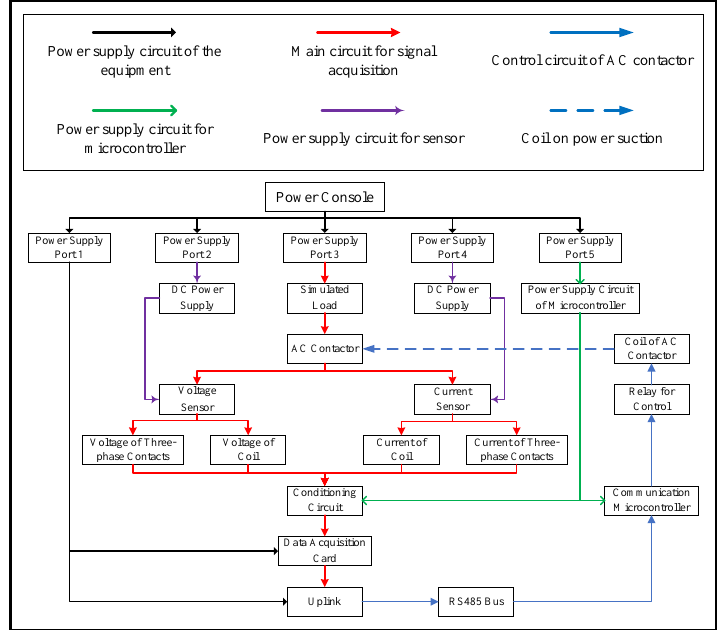
Figure 5. Schematic diagram of the hardware circuit.